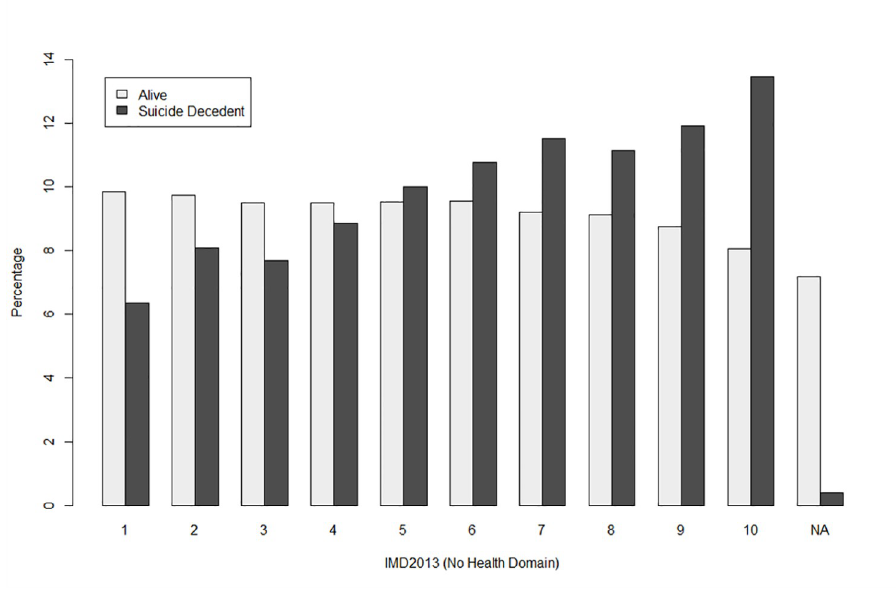
Fig 2. Distribution study cohort by status at the end of the study period and deprivation measured by IMD2013. IMD2013 Decile 1 represents the 10% least deprived areas in New Zealand and Decile 10 represents the most deprived.